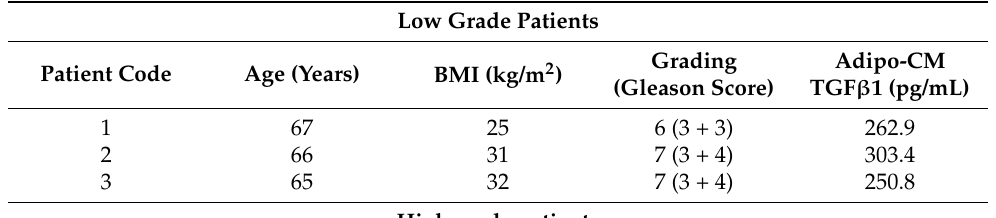
Table 1. Clinicopathological characteristics of patients.